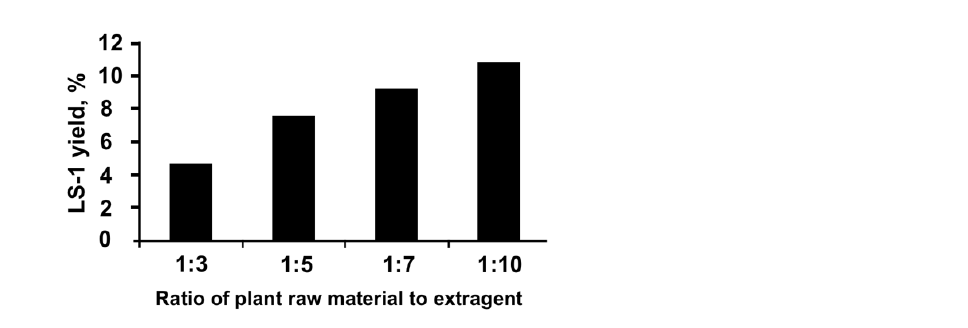
Figure 1. Elaborating optimal technology for LS-1: choosing the correct ratio of raw material to extragent.